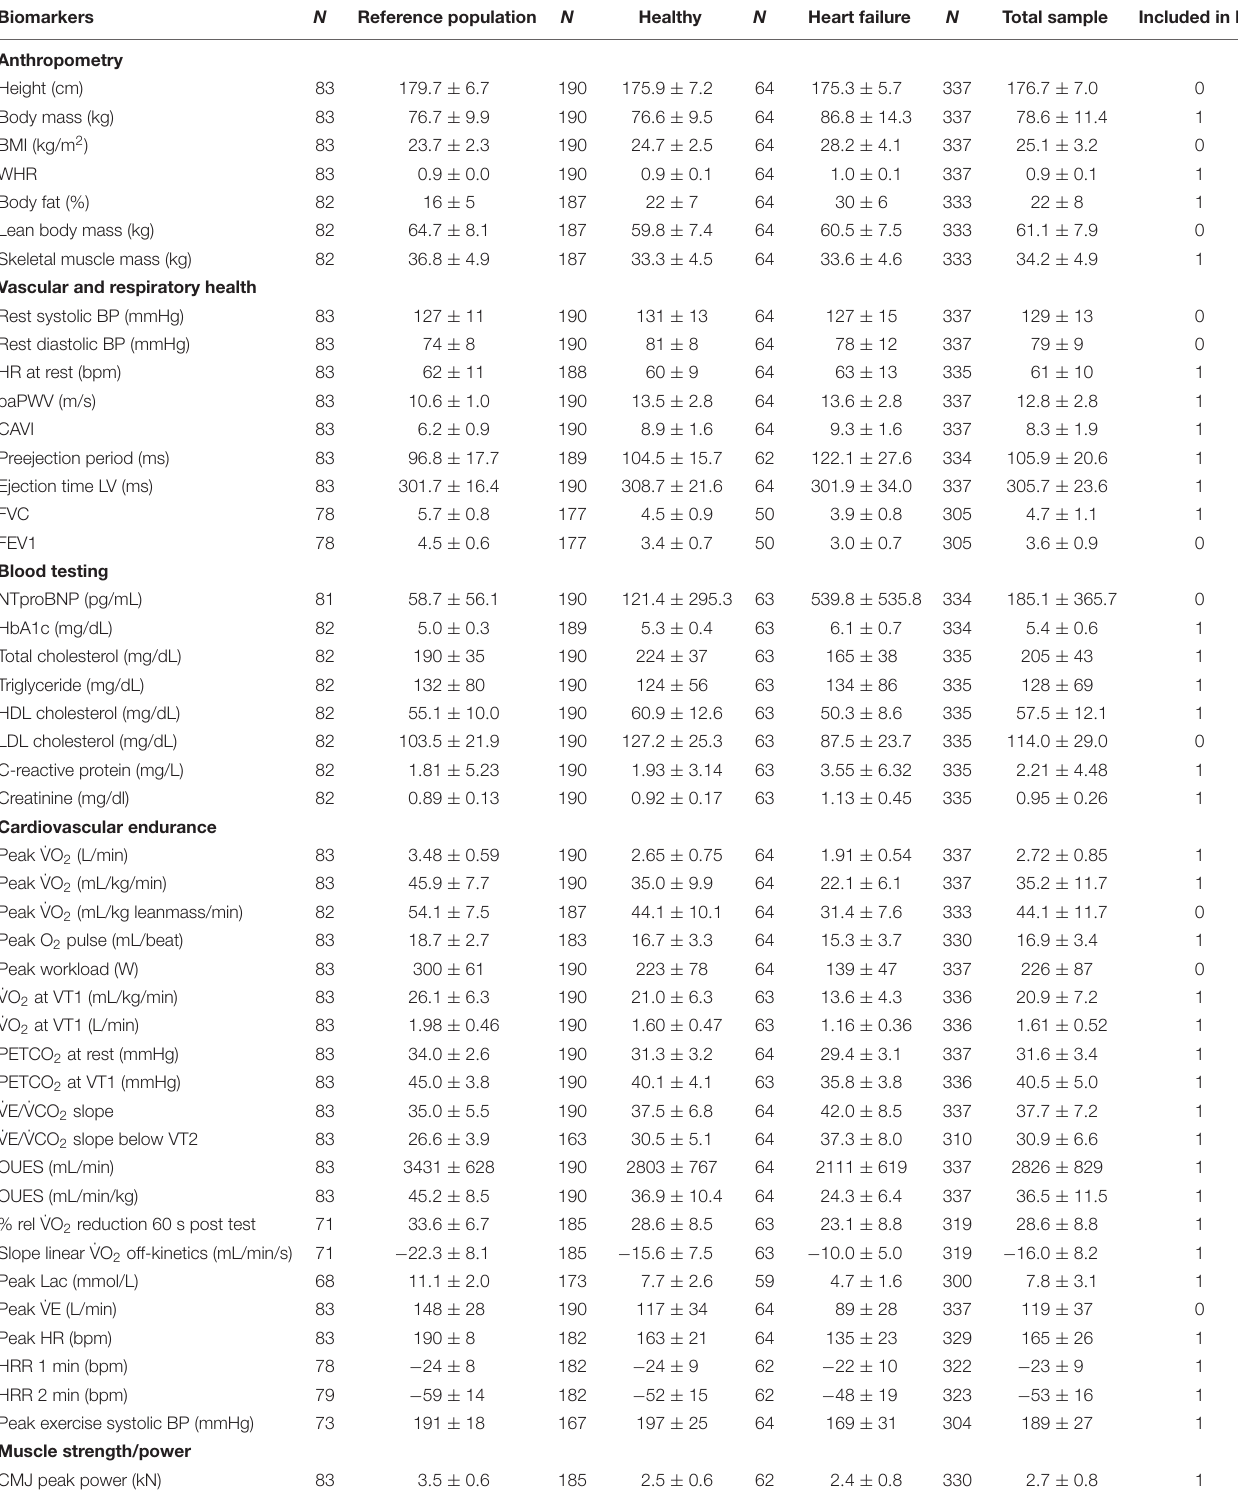
TABLE 2 | Descriptive statistics of the male participants separated into Reference Population (healthy participants aged ≤ 39 years), Healthy (healthy participants aged ≥ 40 years), and Heart Failure (patients with heart failure). Data are presented as mean ± standard deviation if not stated otherwise. Biomarkers N Reference population N Healthy N Heart failure N Total